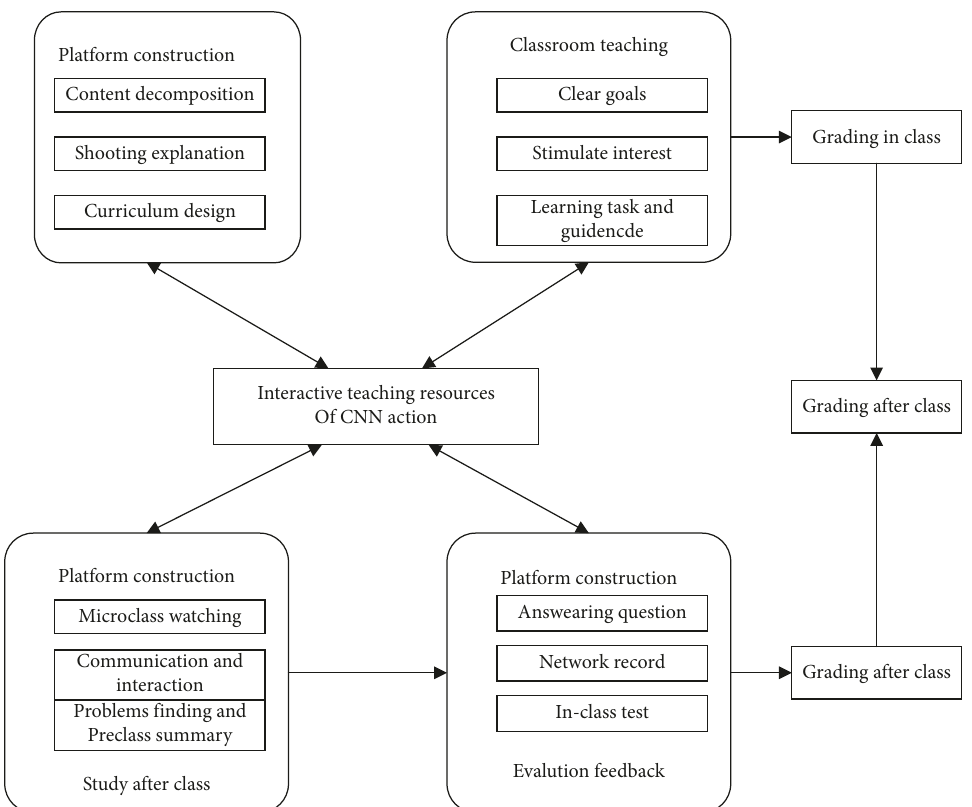
Figure 3: Schematic diagram of mixed teaching mode for international trade major students based on